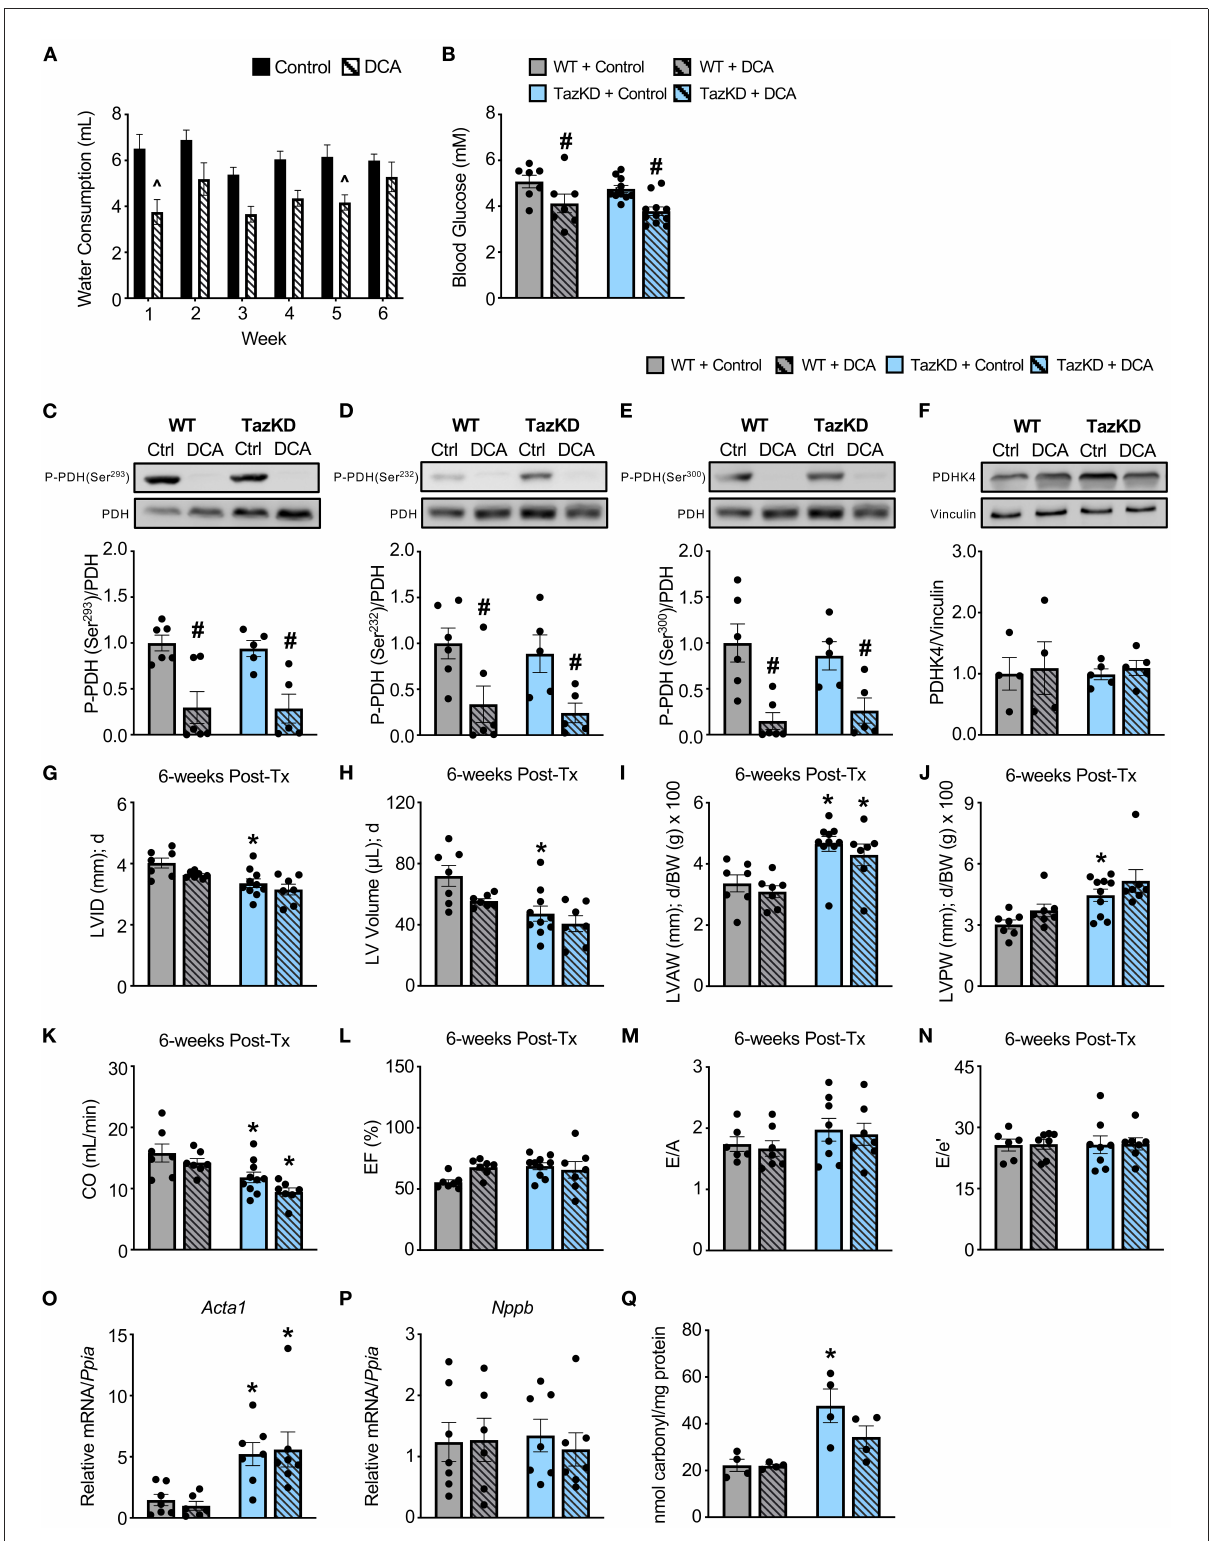
FIGURE2 DCA treatment decreases inhibitory PDH phosphorylation but fails to alleviate the cardiac structural abnormalities in TazKD mice. (A) Average daily consumption of water or water supplemented with DCA (70mM) reported per individual mouse for each week of the